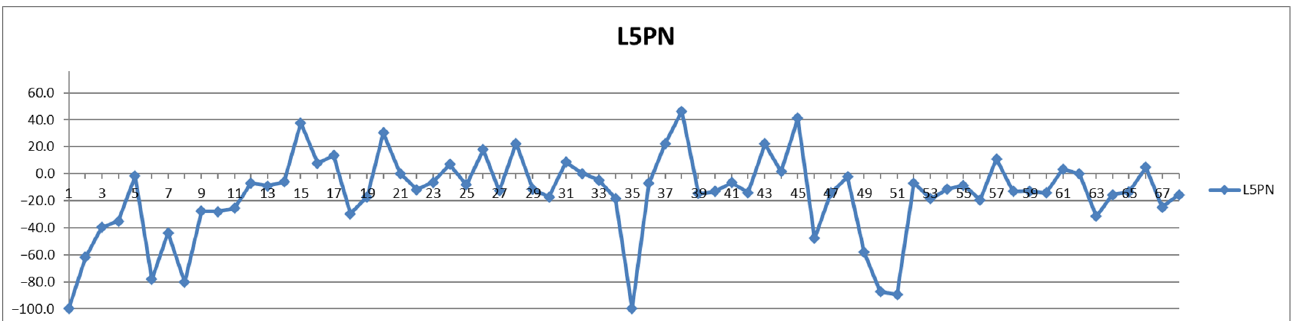
Figure 3. Small LDL particle number (nmol/L) subfraction L5PN in fasting (blue) and postprandial (red) status for control cases (1–29) and CVD cases (30–68).